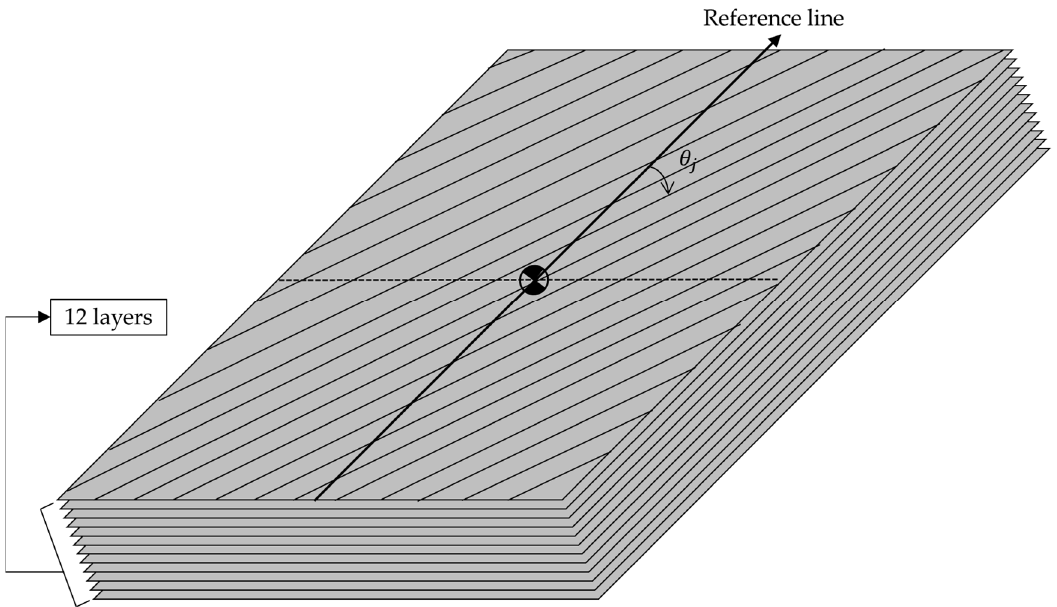
Figure 4. Simple rectangular UCBC specimen with 12-layered UD prepreg and carbon fiber orienta- tion θ j